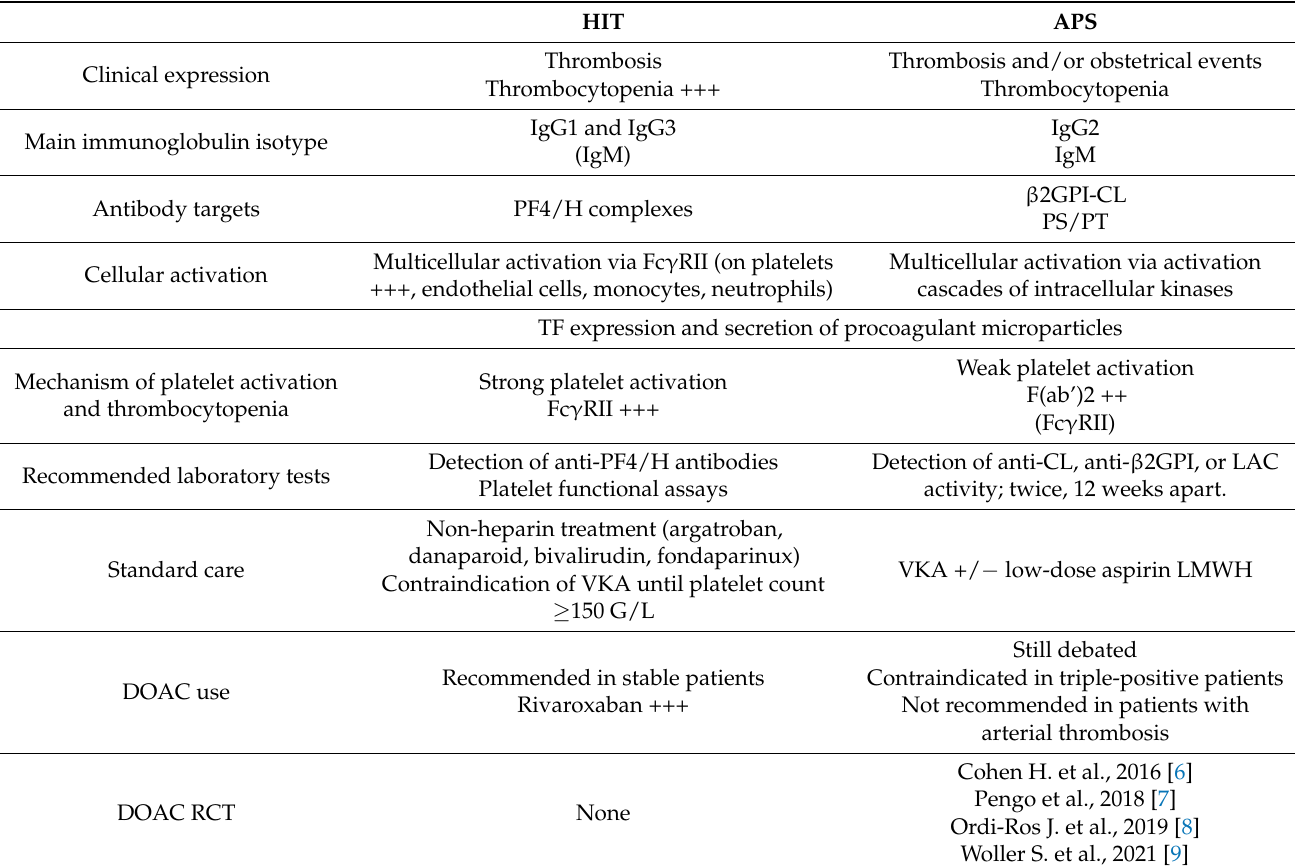
Table 1. Comparison of HIT and